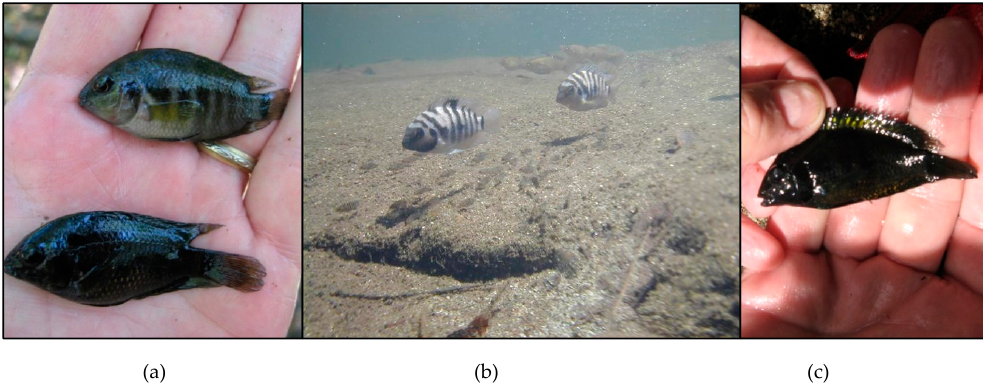
Figure 5. Color phases of convict cichlids. Males alternate between drab olive-gray when non reproductive as in the upper fish in ( a ), to contrasting black and white when defending young (female is ahead of the male in this image) ( b ). Females have an additional color phase when gravid and courting males in which the background color become black as in the lower fish in ( a ), image ( c ), which provides a striking contrast for gold flecks on the belly and yellow and blue pigments in the fins and throat. Photos of fish in hand by Brian Wisenden, photo of breeding pair ( b ) by Terence